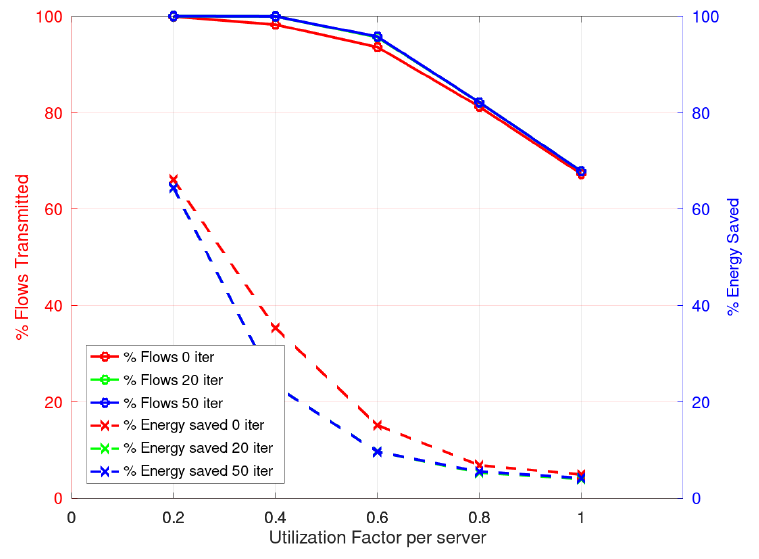
Figure 6. Simple heuristic, flow scheduling.